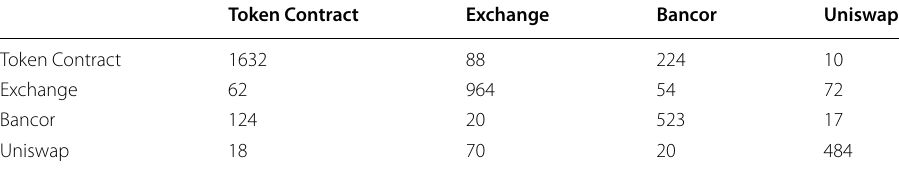
Table 11 Values of some quality metrics obtained by applying our classification algorithm with the original Eros distance on testing data Metric Value Accuracy 0.75 Micro Average Precision 0.74 Macro Average Precision 0.62 Micro Average Recall 0.74 Macro Average Recall 0.63 Micro Average F1-Score 0.76